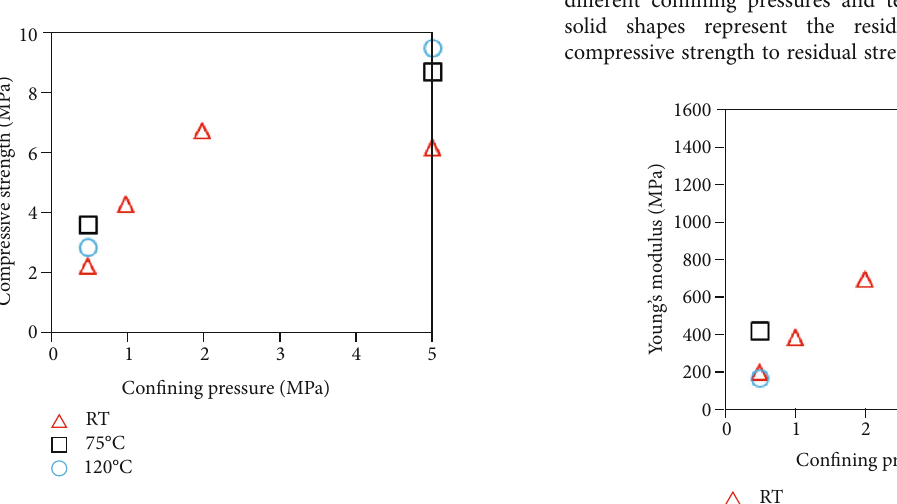
Figure 9: Characteristics of oil sand compressive strength under di ff erent con fi ning pressures and temperatures.